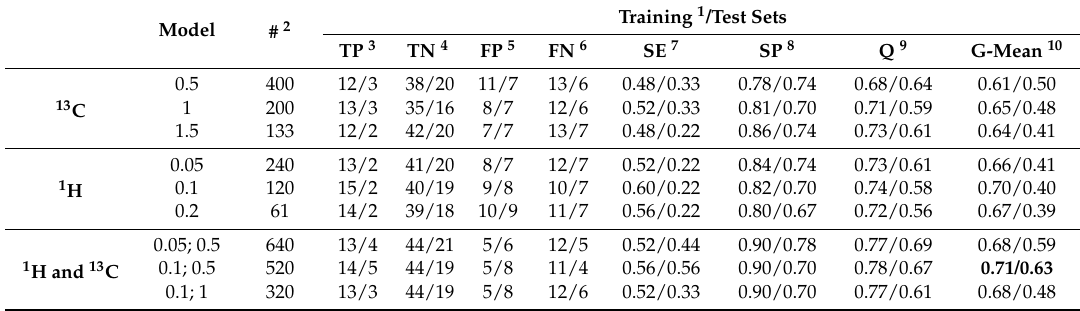
Table 7. Exploration of three collections of NMR descriptors for the QSAR RF model of HCT116 activity classes for the training and test sets. The best models are highlighted in